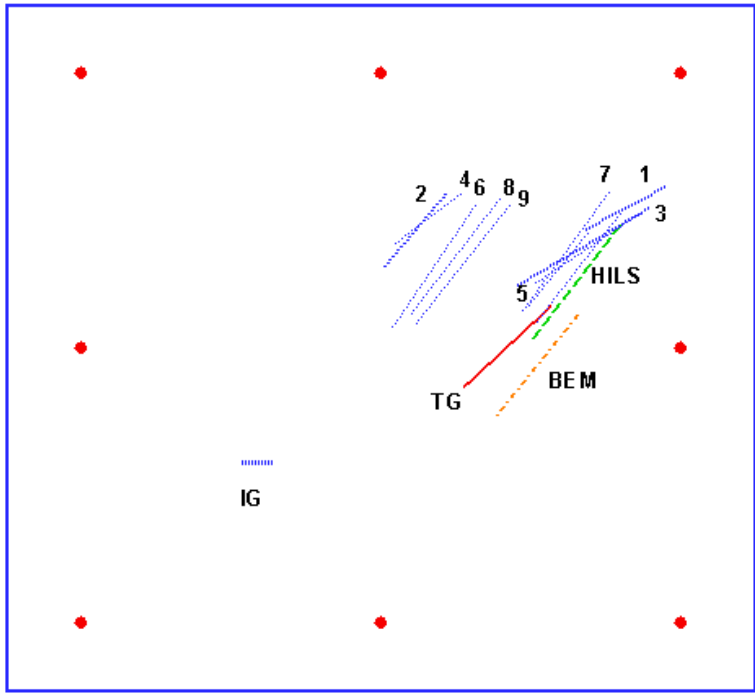
Figure 11. Procedures of crack identification by using multiple loading modes. Red points are sensor positions. No. 1–9 is the first nine identified results of different error tolerance e .